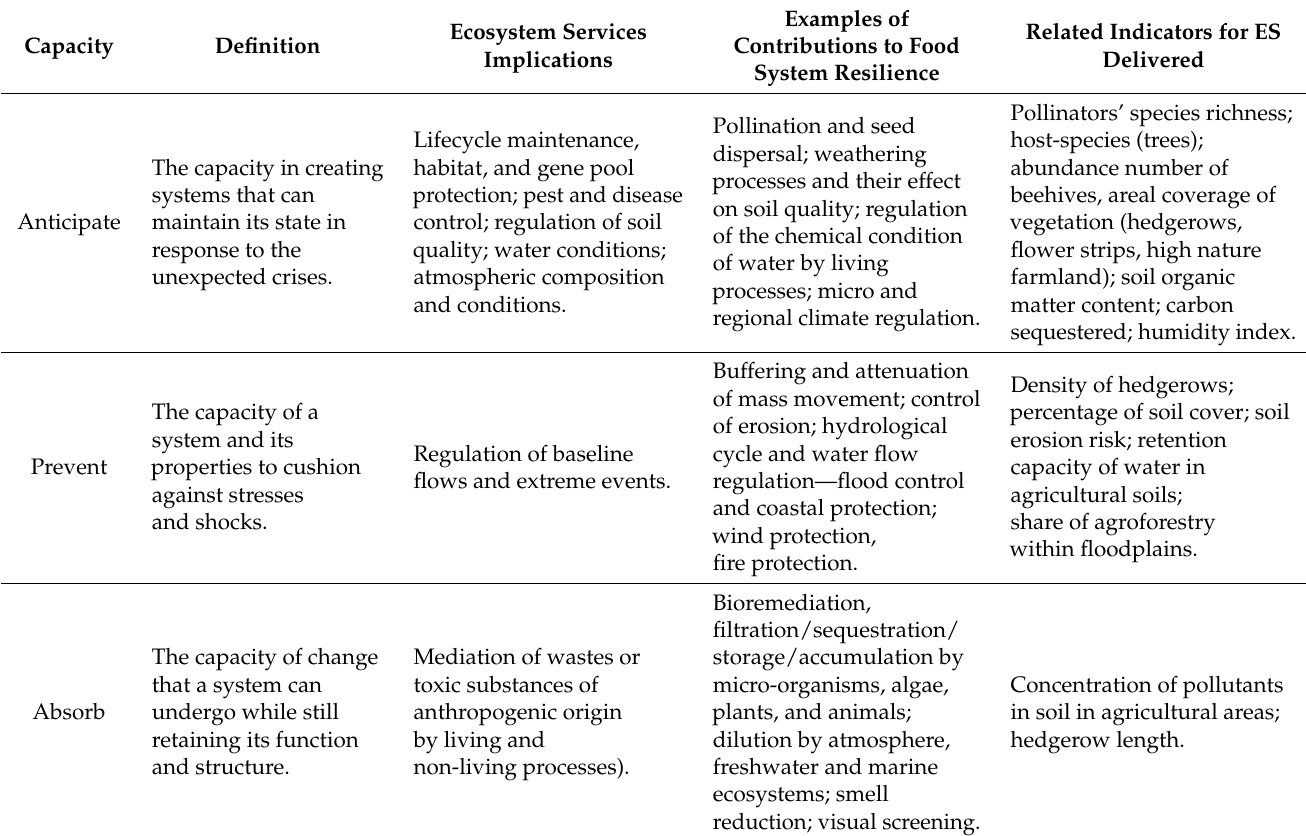
Table 1. Ecosystem services contribution to food systems